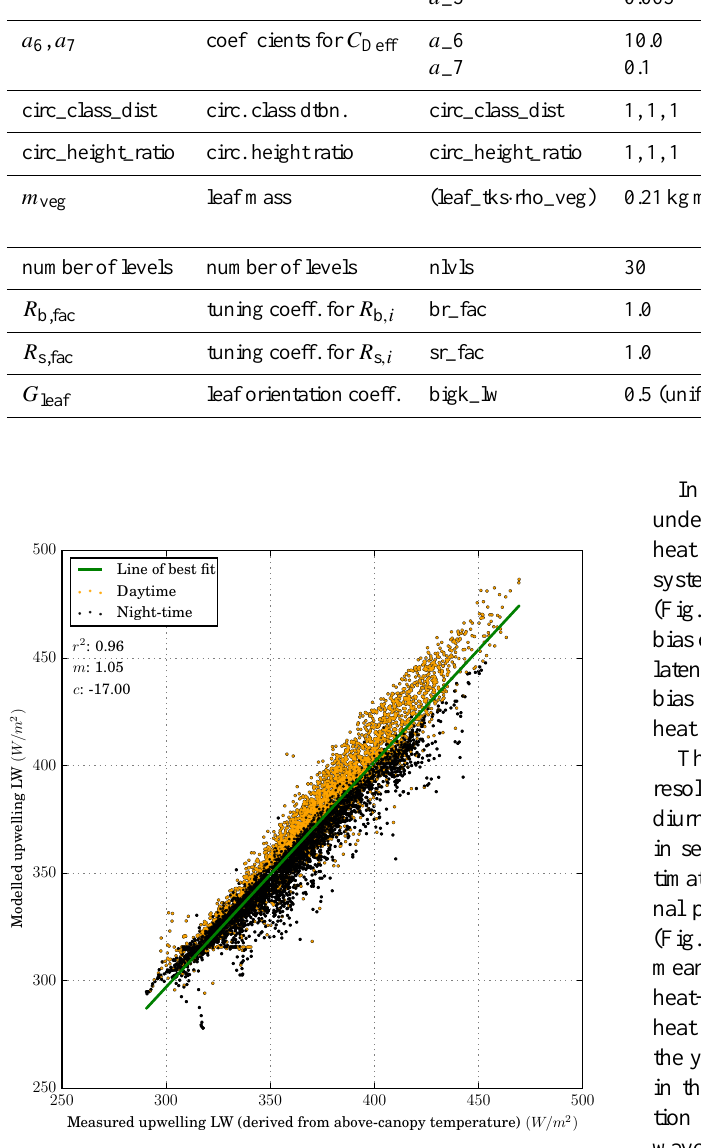
Figure 3. Correlation of observed upwelling long-wave radiation (derived from the measured above-canopy temperature) and the up- welling long-wave radiation that is simulated by ORCHIDEE-CAN. Night-time data (corresponding to a downwelling shortwave radia- tion of < 10Wm − 2 ) are plotted in black, and daytime data are plot- ted in